Question: Looking at the figure, what chart type is it?
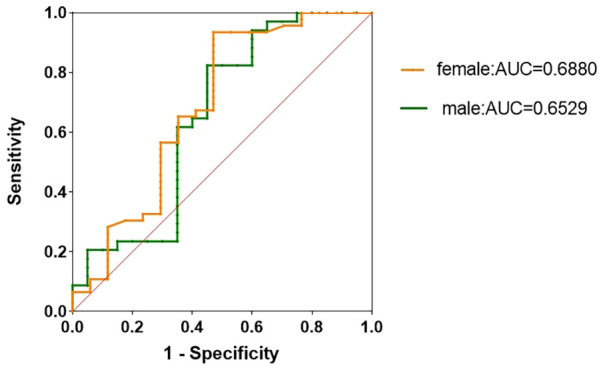
Answer: line